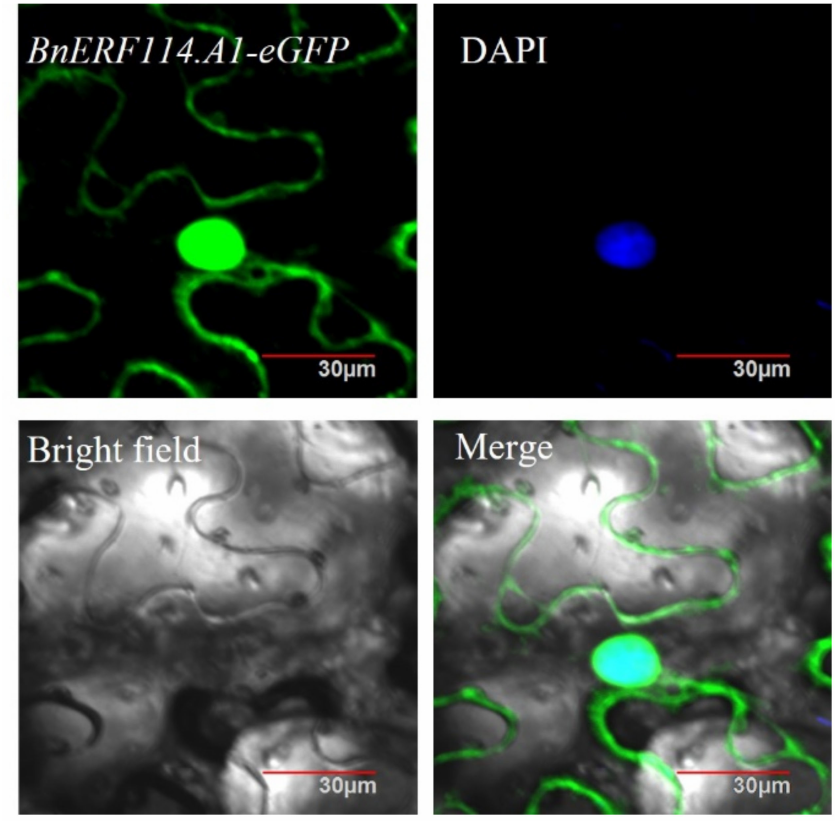
Figure 3. Subcellular localisation of BnERF114.A1. Transient expression vector 35S::BnERF114.A1- eGFP was introduced into Nicotiana benthamiana leaf cells. The infected leaf was stained using DAPI as nuclear localisation marker. Bars = 30 µ